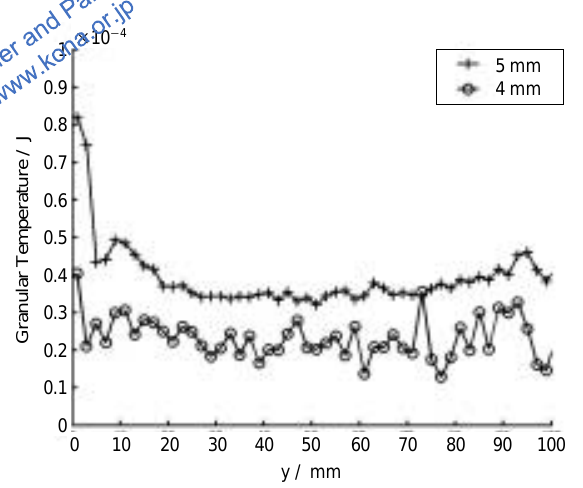
Fig. 10 Granular temperature profiles of each of the phases in the binary